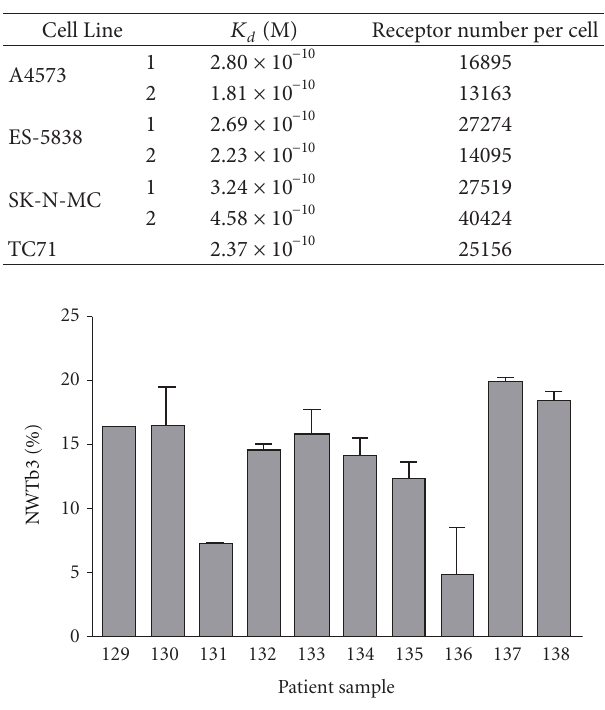
F 1: Quanti�cation of IGF-1R in patient tumor samples by sandwich ELISA, detected using NWTb3 positive